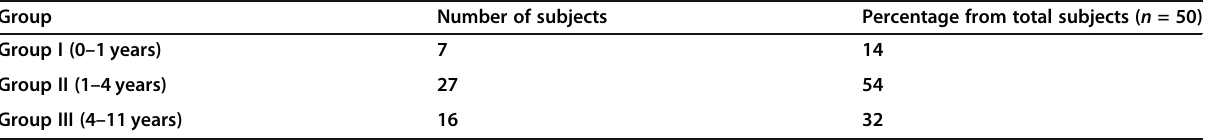
Table 2 Classification of subjects according to their age at presentation ( n = 50) Group